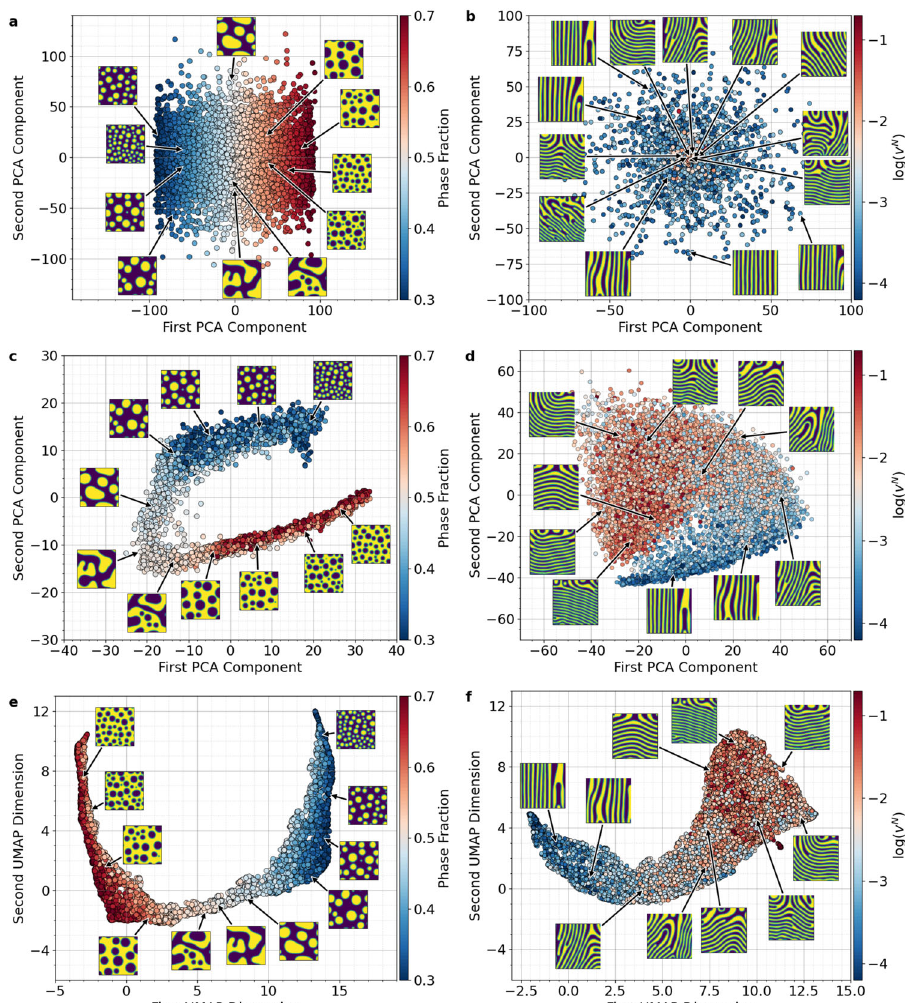
Fig. 2 Latent representations of various microstructural patterns. Spinodal decomposition of a two-phase mixture representations are displayed in left panels, physical vapor deposition of a binary alloy thin fi lm representations in right panels. a , b These panels show the projection using a linear embedding technique (PCA) directly on the microstructure images (de fi ned as dimensionality reduction on the ambient space). c – f Second and third rows show the projection of the ResNet-50 v2 latent vector using PCA (panels c and d ) and UMAP (panels e and f ). Latent vectors are colored according to relevant input process parameters for both problems, namely the phase fraction ( f ) for spinodal decomposition and the normalized deposition rate (v N ) for physical vapor deposition. De fi nition of the normalized deposition rate is provided in Methods. For the microstructure insets across both spinodal and physical vapor deposition problems, yellow denotes the A phase, and purple the B